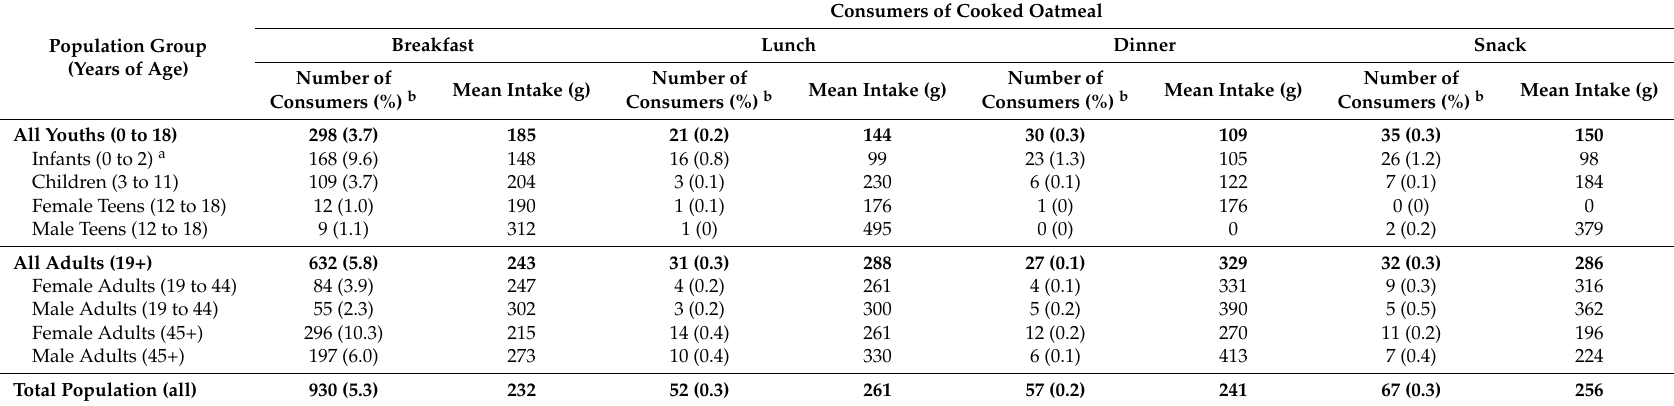
Table 3. Prevalence of consumption and intakes of cooked oatmeal at each eating occasion (data from Day 1 of the 2009–2012 NHANES).